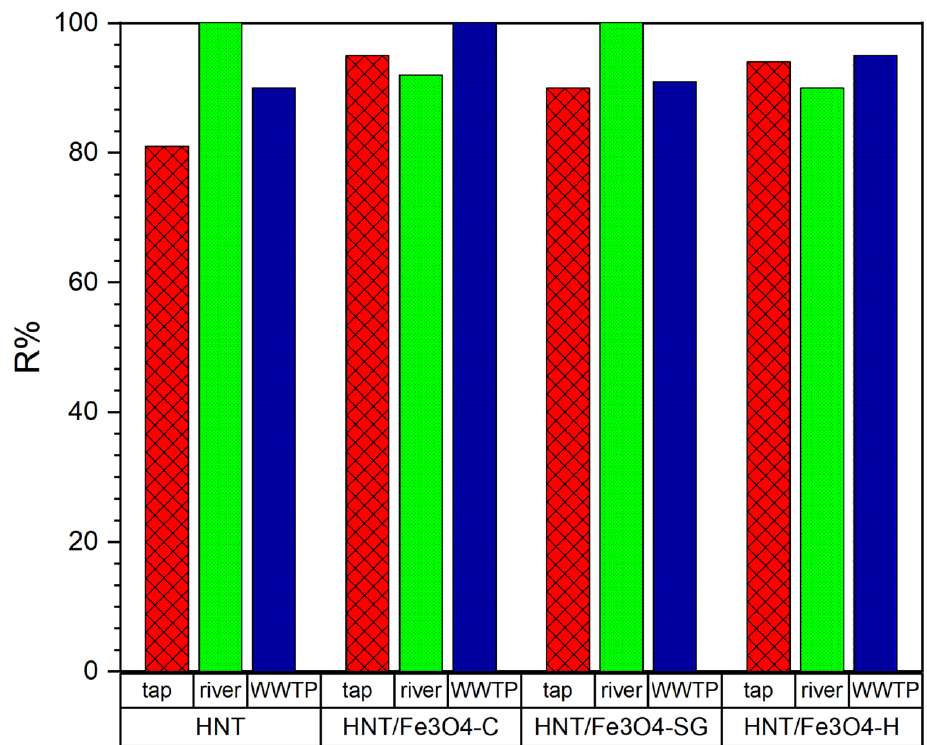
Figure 9. OFL removal (%) from tap and river water samples and effluent from WWTPS with HNT, HNT/Fe 3 O 4 -C, HNT/Fe 3 O 4 -H, and HNT/Fe 3 O 4 -SG (Experimental conditions: sorbent 20 mg, 10 mL tap water, OFL initial concentration 10 µg L − 1 , n = 3, RSD < 10%).